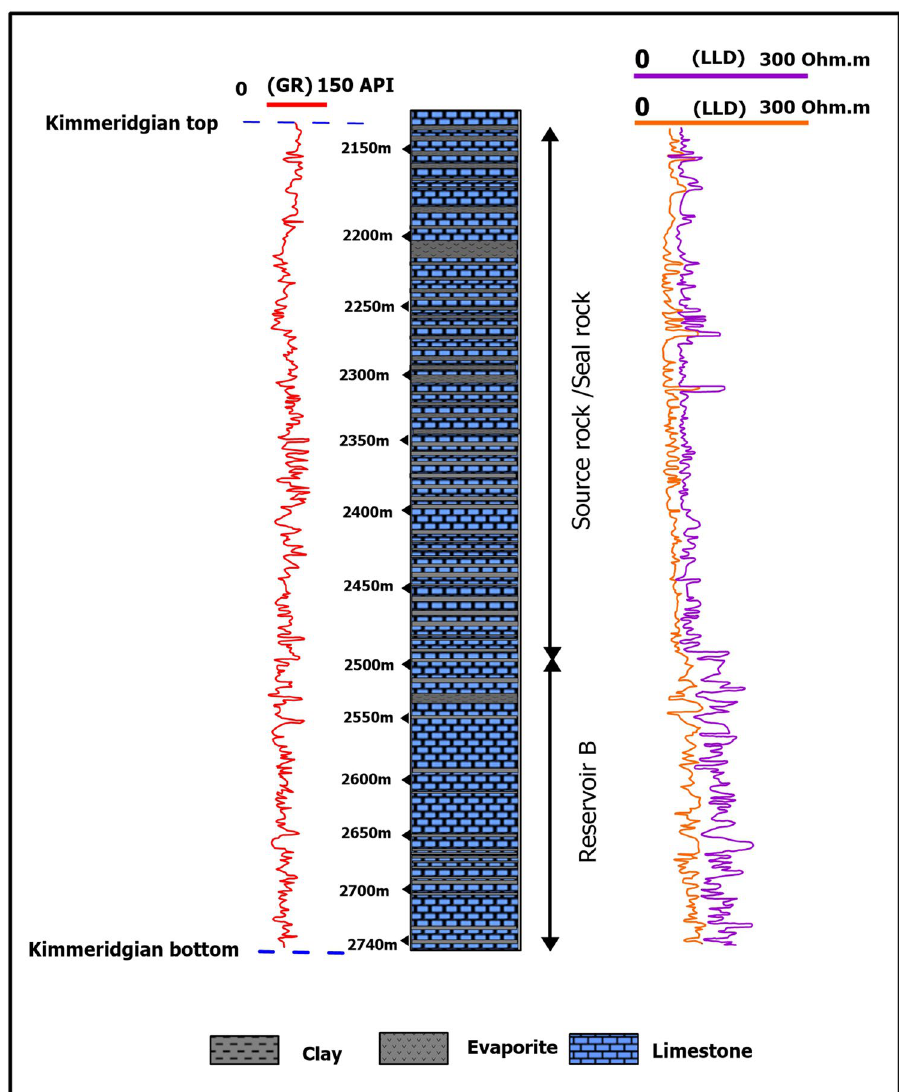
Fig. 7 Characterization of the Kimmeridgian series using well logs (W1